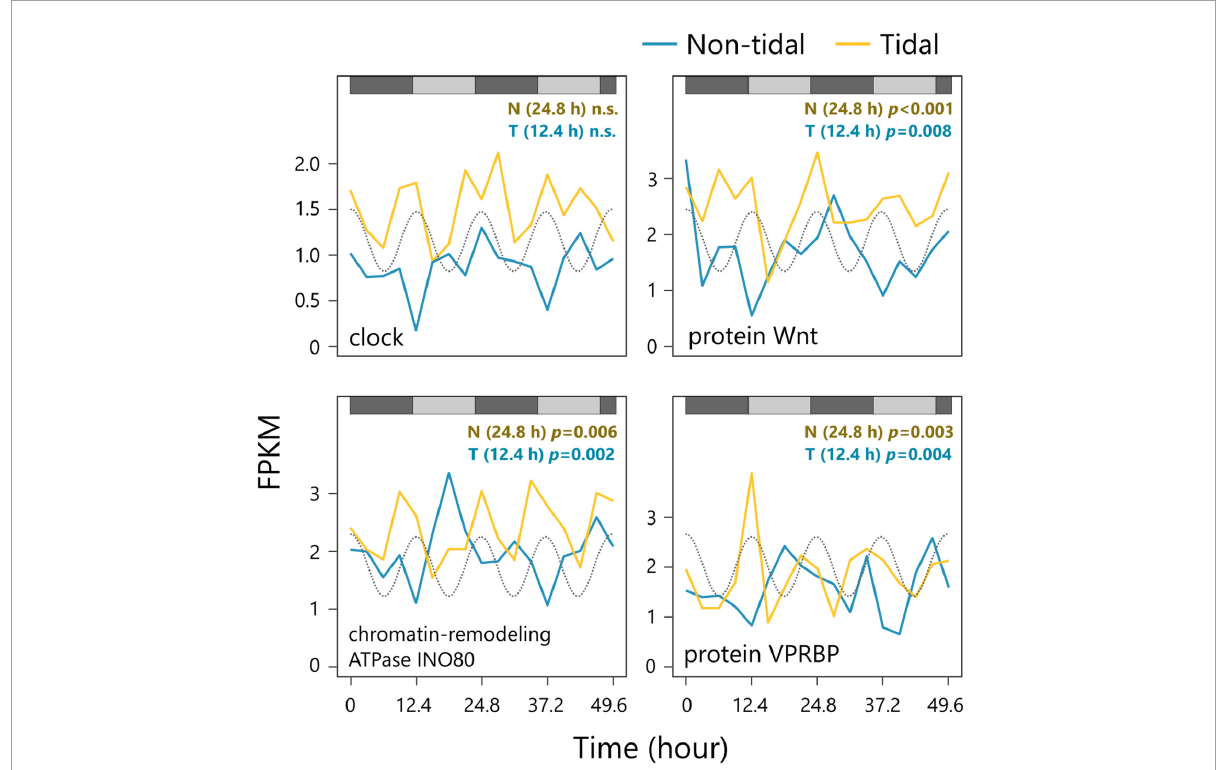
FIGURE3 Examples of the expression patterns of the circadian clock gene (upper left) and oscillating genes with a different period between non-tidal and tidal populations ( upper right , bottom right , and bottom left ). The tide level of the natural environment is shown as a gray dotted line. The gray and black bars represent the subjective day and night, respectively. Rhythmicity of a period of 12.4 and 24.8 h were tested using RAIN for tidal (T) and non-tidal (N) populations,